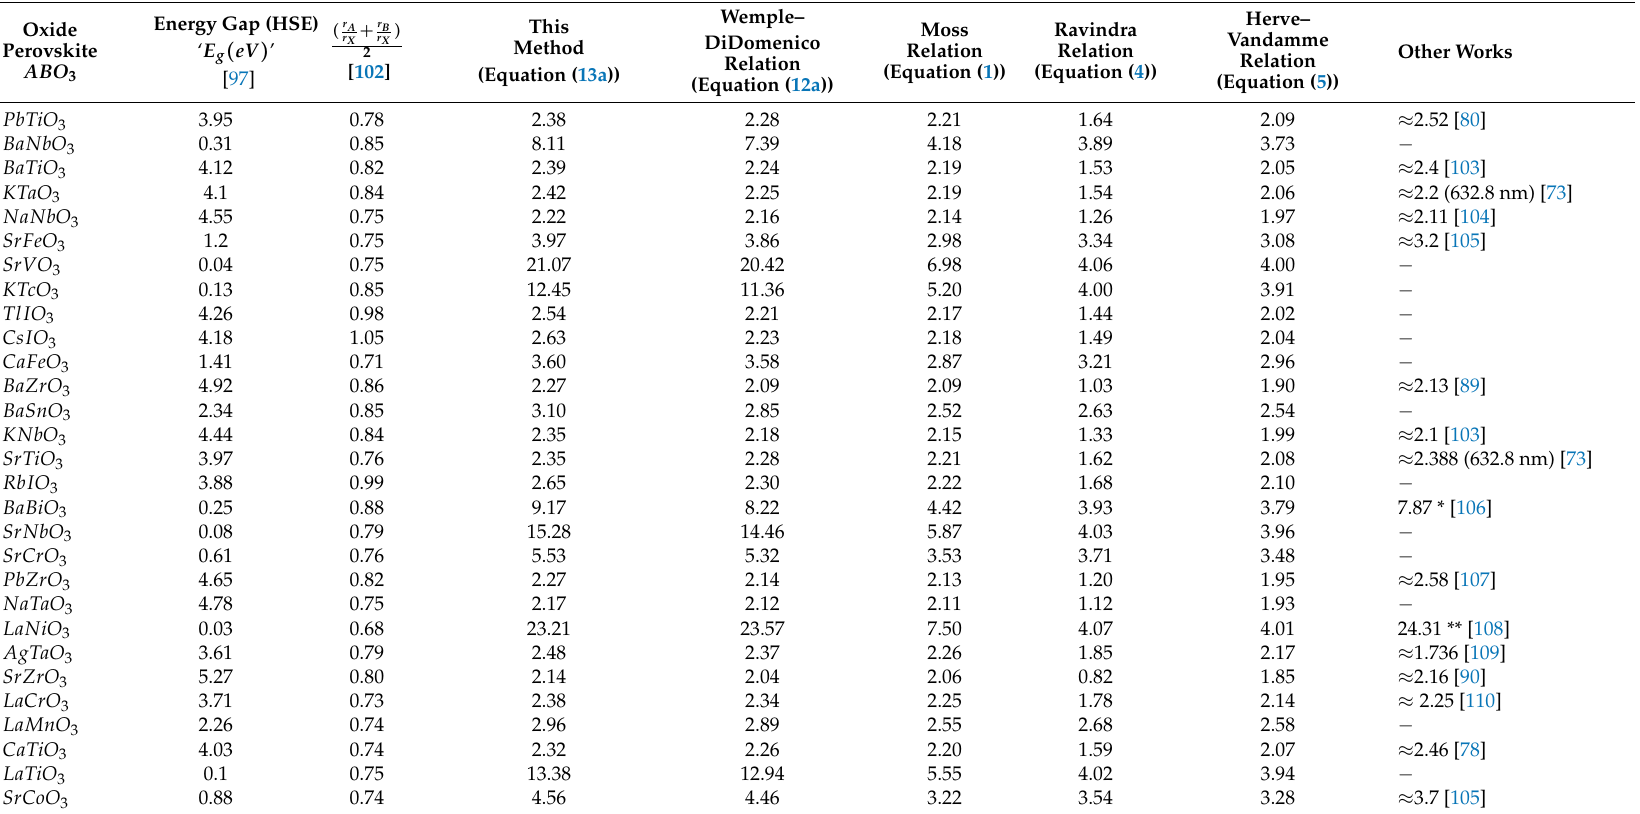
Table 2. Energy gap of various oxide perovskites with their corresponding refractive indices computed from various models. Oxide